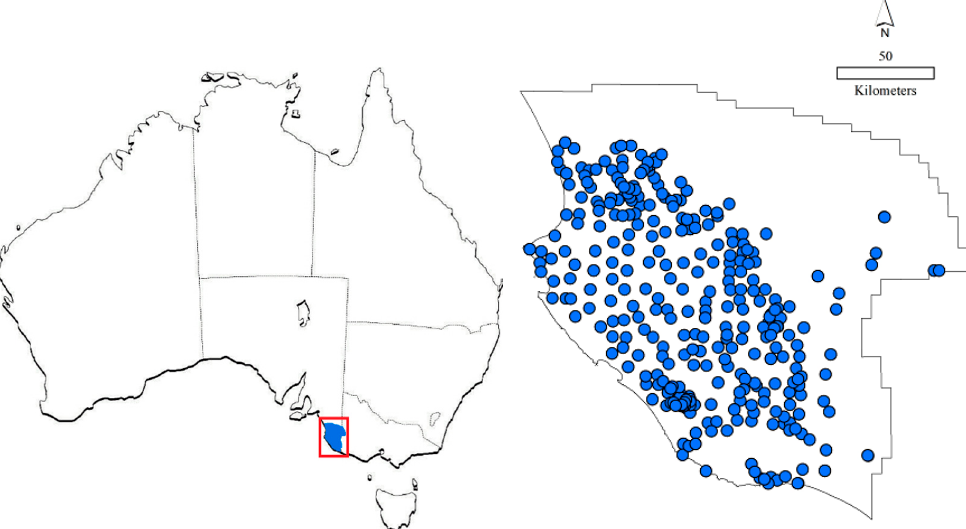
Figure 1. The study area and 465 groundwater bores (The blue area in the red rectangle in the left panel represents the study area in Australia; and the borders in the right panel represents the study area, within which blue points represent the locations of 465 bores).